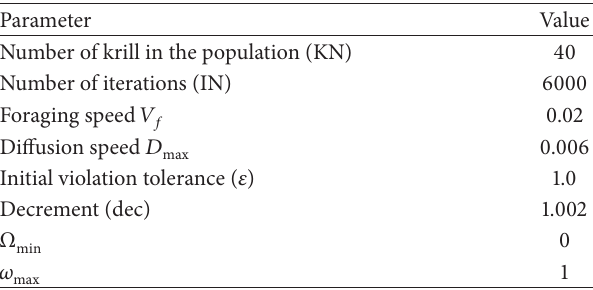
Figure 2: LU cost for various CMR values.